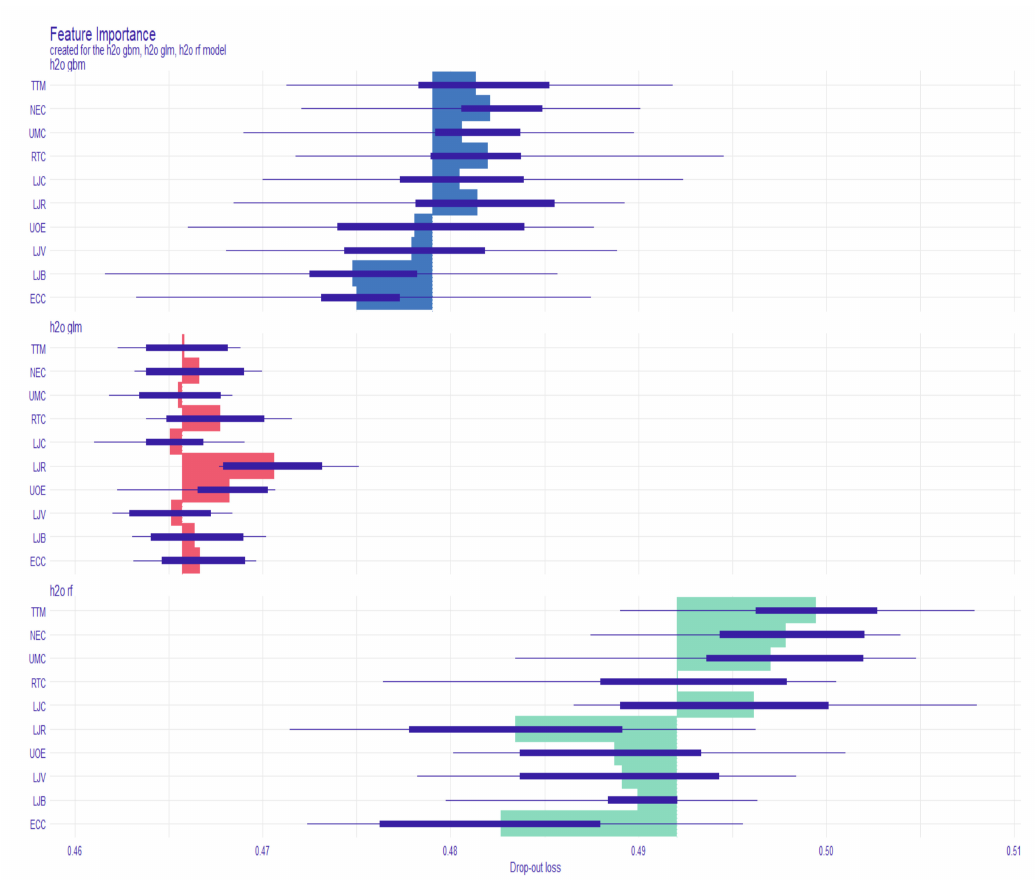
Figure 3. Importance of the research predictors based on the general linear model (GLM), random forest (RF), and gradient boosting machine